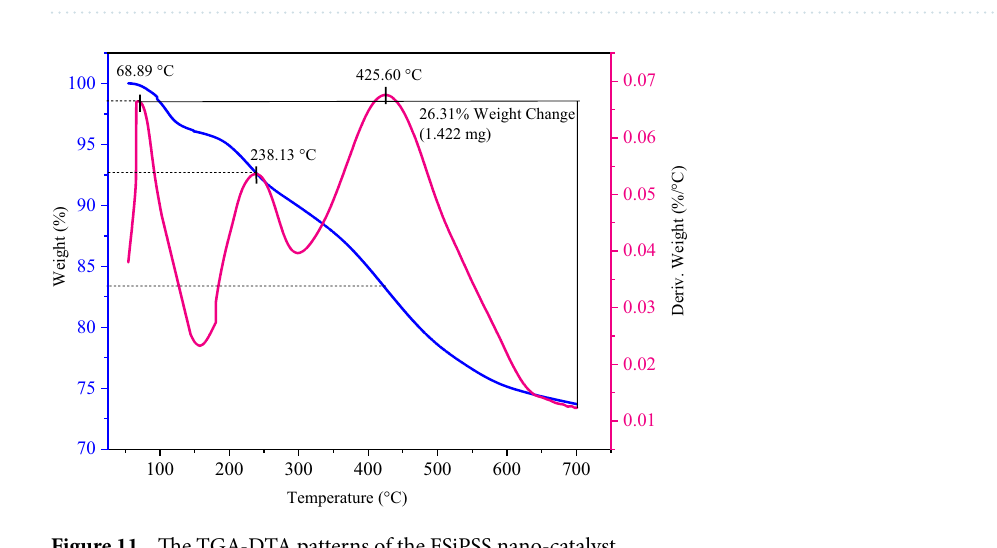
Figure 10. The particle size distribution (histogram) of the FSiPSS nano-catalyst.